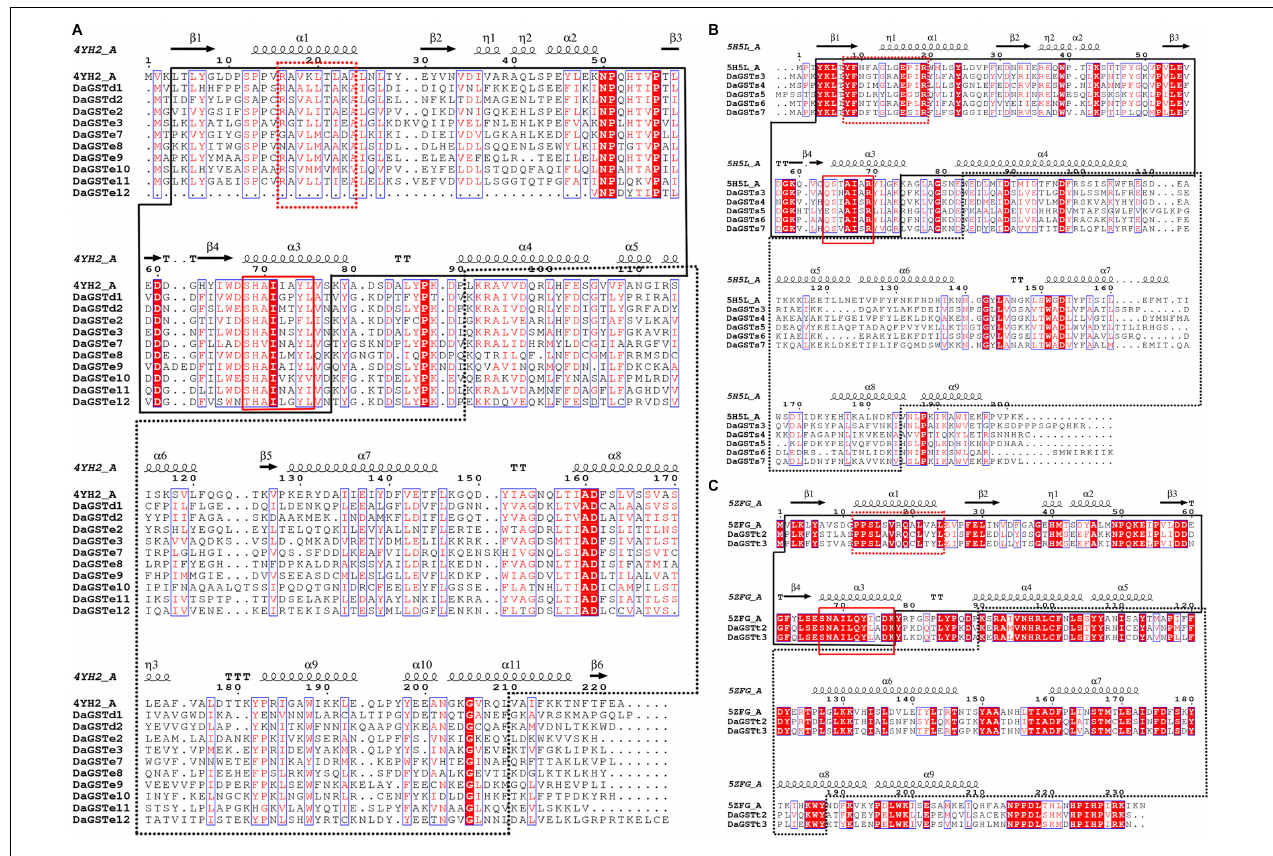
FIGURE 2 | Multiple sequence alignment and secondary structure element assignment of GSTs from Dendroctonus armandi . The alignment included DaGST s (delta, epsilon, sigma, and theta) and the predicted Drosophila melanogaster glutathione S-transferase e6 protein sequence (PBDID: 4YH2, Chain: A) (A) , prostaglandin synthase D of Nilaparvata lugens glutathione S-transferase s2 protein sequence (PBDID: 5H5L, Chain: A) (B) and prostaglandin synthase D of silkworm ( Bombyx mori ) glutathione S-transferase (PBDID: 5ZFG, Chain: A) (C) . Alpha helices are marked as alpha or beta based on automatic assignment according to the template for the three (glutathione S-transferase e6, glutathione S-transferase s2, and glutathione S-transferase) protein structures in ESPript. The black solid line box region is the GST N-terminal domain; the dashed line box region is the GST C-terminal domain; the red solid line box region is the characteristic GST motif; the red dashed line box region is the characteristic motif of different families of